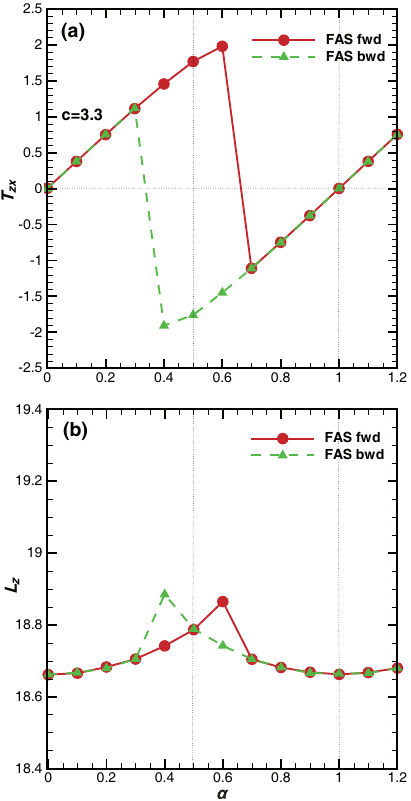
Fig. 3 Shear stress profile ( T vs register  ) and the mean zx separation profile ( L vs. register  ) of the thin-film lubrication z system with T = –1.0 (forward, a solid 1 9    at T =0.15 and zz fs line with circles; backward, a dashed line with